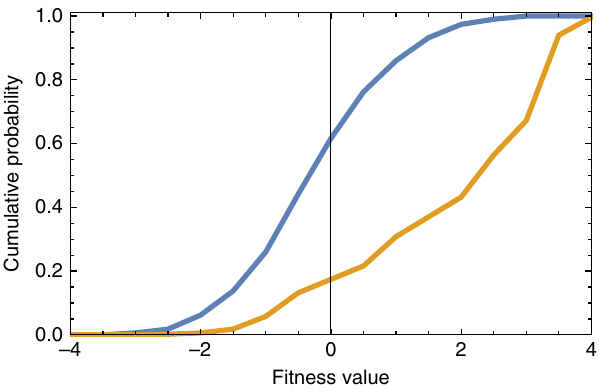
Fig. 4 Genetic algorithm (GA) fi tness distribution. The cumulative distribution of fi tnesses both at the beginning (shown in blue) of the GA and after 1000 generations (shown in orange). Clearly, the alloy distribution better matches the hardness criterion after many